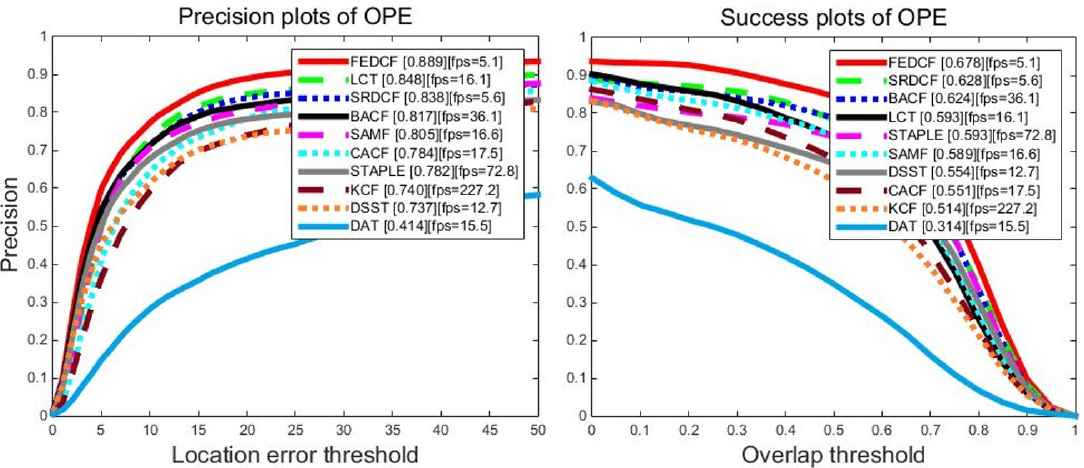
Figure 8. The precision plots and success plots of FEDCF and compared trackers with one-pass (OPE) evaluation on OTB2013, where 50 video sequences contain 11 challenging attributes.